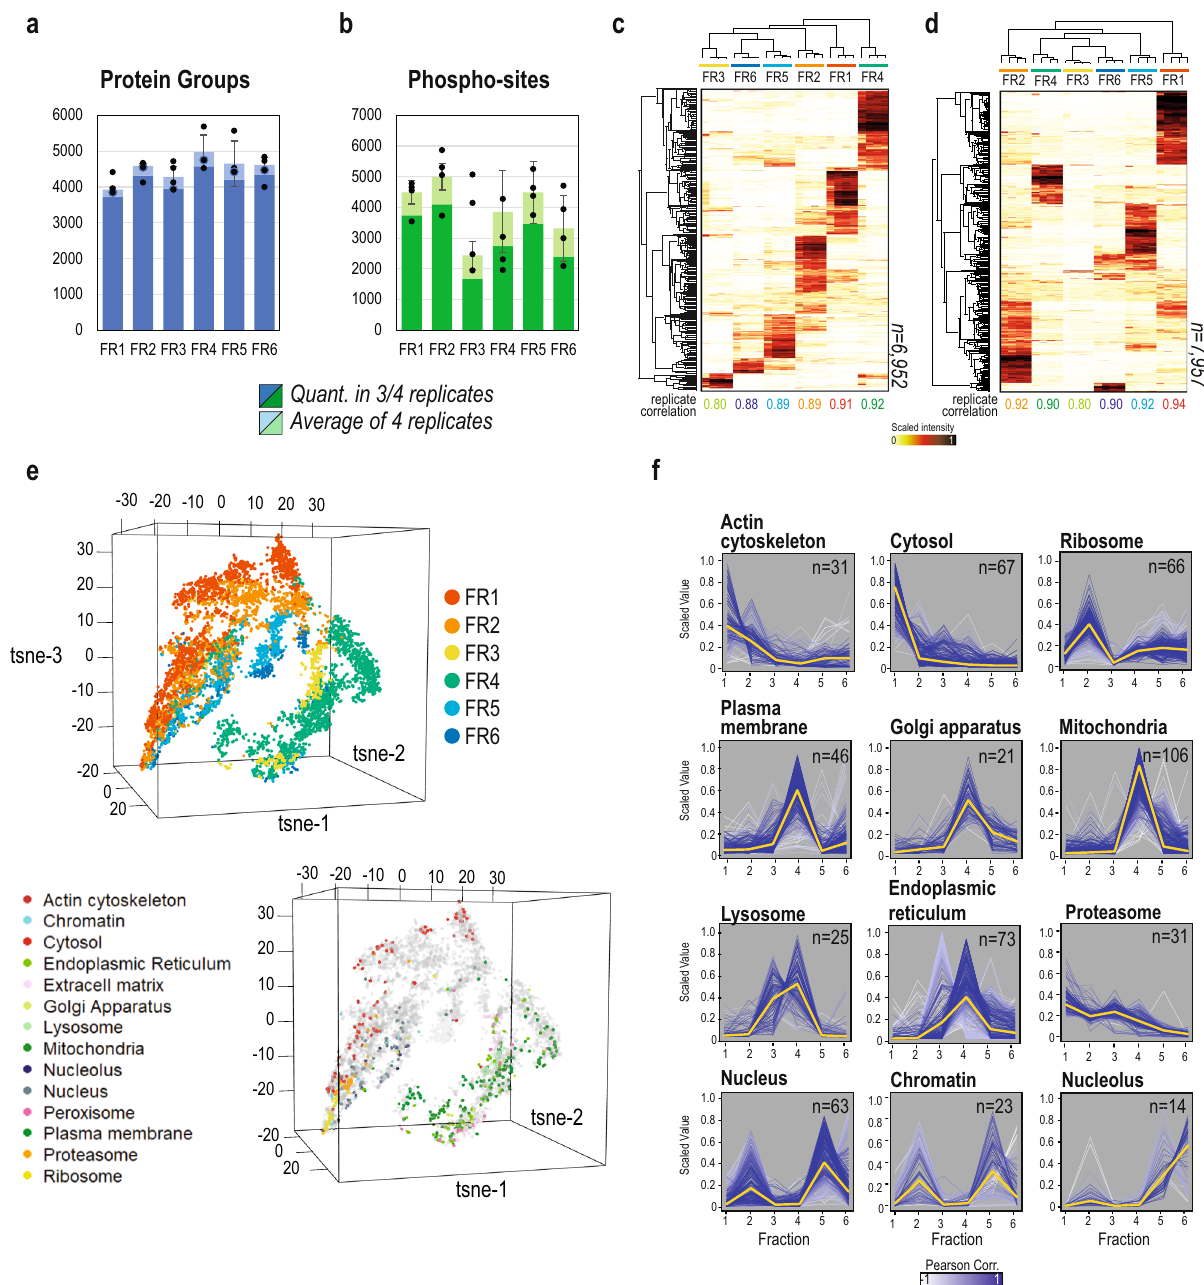
Fig. 2 Overview of subcellular fractionation resolution and subcellular compartment enrichment. a Bar-plot summary of the identi fi ed proteins in HeLa samples as average of 4 replicates per fraction (light blue bar) and quanti fi ed proteins in at least 3 replicates (dark blue). Height of the bars represents the mean number of identi fi cations of n = 4 experimental replicates, and error bars represent the standard deviation in identi fi cation numbers between replicates. b Bar-plot summary of the identi fi ed phosphorylation sites in HeLa samples as average of 4 replicates per fraction (light green) and quanti fi ed phosphorylation sites in at least 3 replicates (dark green). Height of the bars represents the mean number of identi fi cations of n = 4 experimental replicates, and error bars represent the standard deviation in identi fi cation numbers between replicates. c Heatmap of scaled intensities per replicate, of four replicates, of the subcellular proteome of HeLa, showing both protein and sample clustering. d Heatmap of scaled intensities per replicate, of four replicates, of the subcellular phospho-proteome of HeLa, showing both phospho-site and sample clustering. e t-SNE plots of log2 transformed intensities of proteins identi fi ed in the subcellular fractionation of HeLa ( n = 4). TOP: The clusters assigned for each fraction in Fig. 2c are used to color-code it. BOTTOM: Markers of different organelles are highlighted in the t-SNE plot. f Pro fi le-plots of cell compartment markers in the subcellular proteome HeLa dataset. Scaled intensity across fractions is plotted for each independent replicate. Gradient of white to blue indicates Pearson correlation to the centroid of each distribution, which is highlighted as a yellow line. “ N ” speci fi es the number of protein markers used to make the pro fi le plots, but the plots show that number of markers for each one of the 4 replicates used experimentally. Source Data for Figs. 2a and b are provided as a Source Data fi